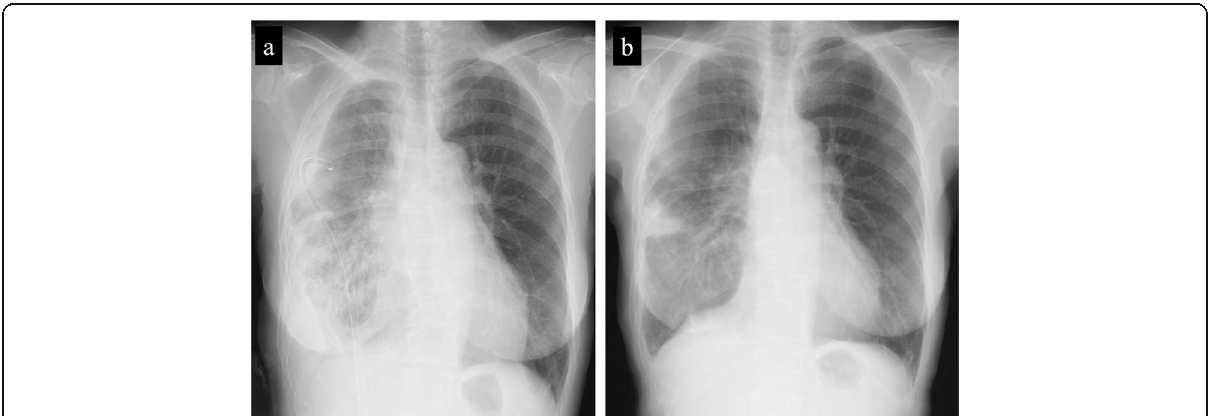
Fig. 1 Chest X-rays at the time of admission and before discharge. Chest X-ray at the time of admission showed remaining pleural effusion and insufficient expansion of the lung, although a drainage tube had been inserted in the right thoracic cavity ( a ). Chest X-ray before discharge showed a slight shadow due to atelectasis, but well expansion of the other part of the lung ( b